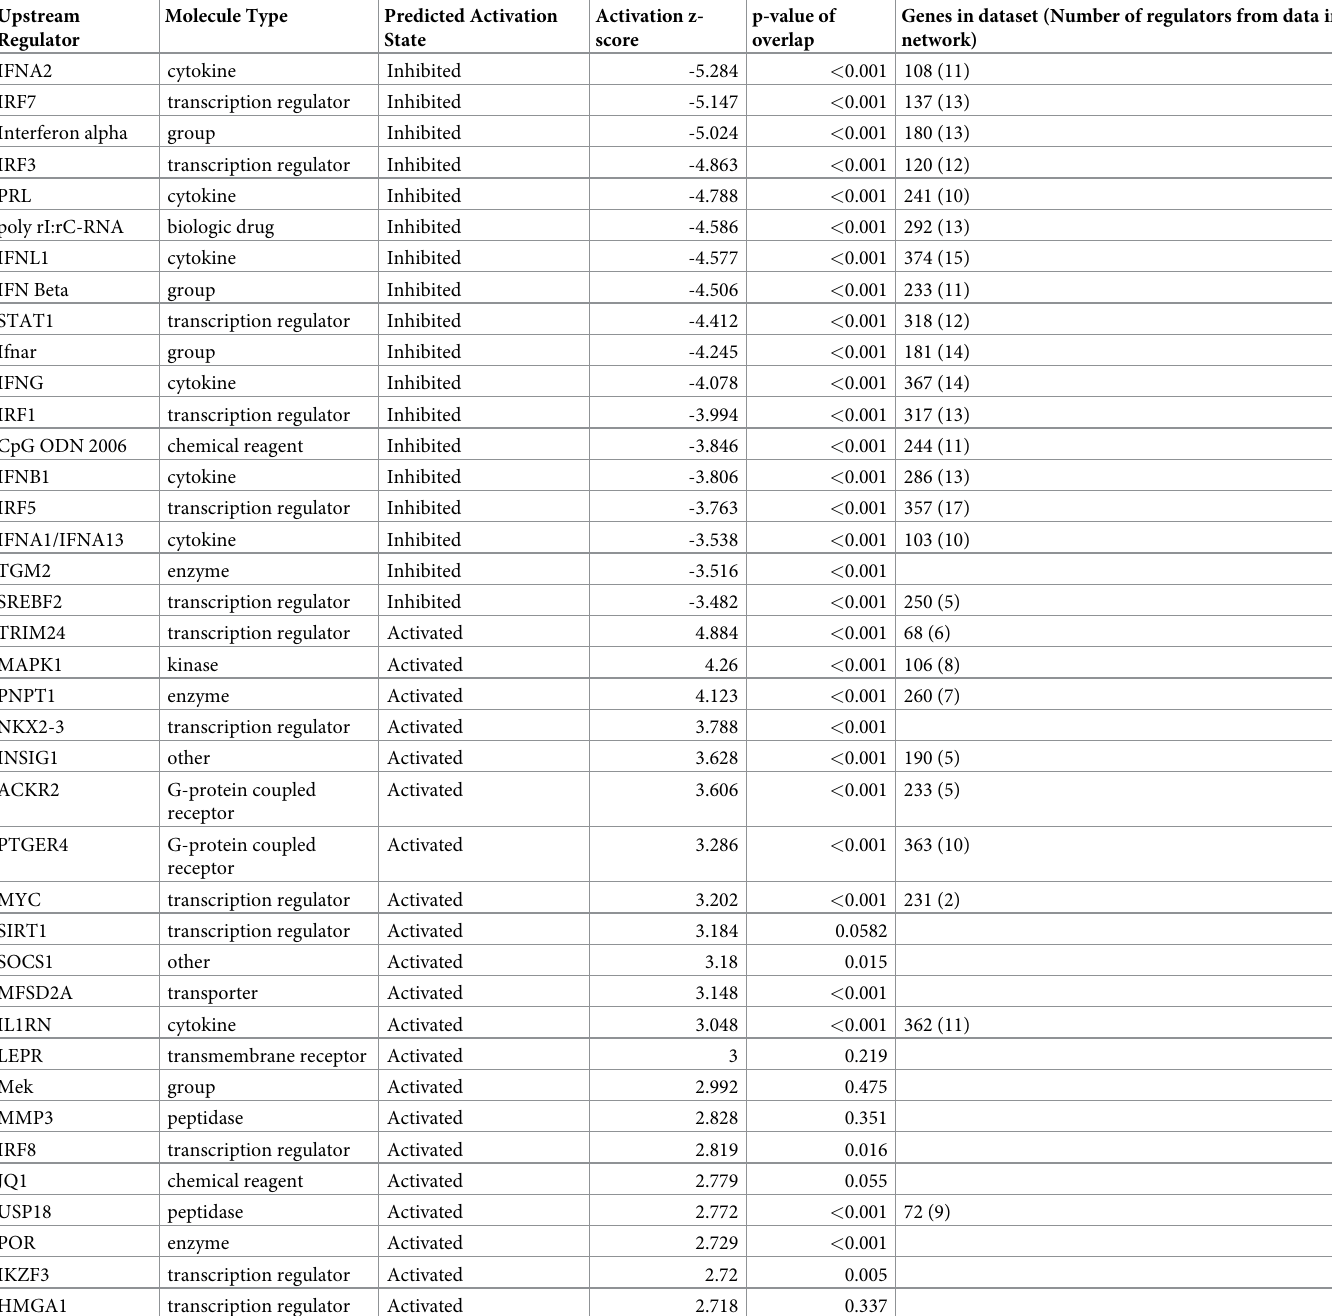
Table 3. Top activated or repressed upstream regulators predicted by IPA from gene targets within the H/S-DE data set. Upstream